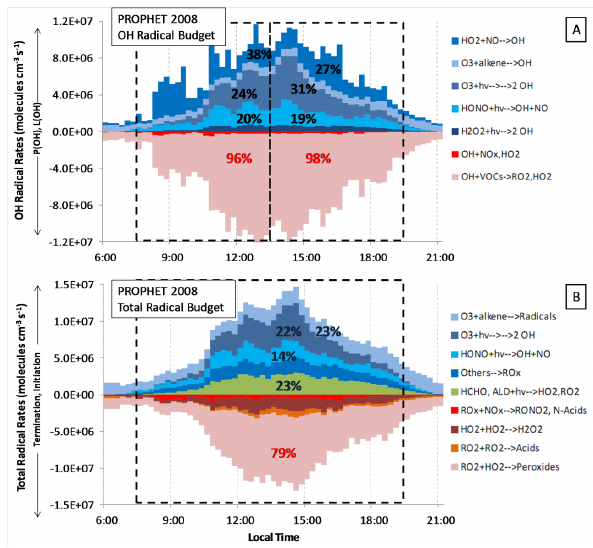
Figure 11: PROPHET 2008 radical budget diagrams showing the campaign median OH radical budget Fig. 11. PROPHET 2008 radical budget diagrams showing the cam- (A) that compares all the production and loss terms (i.e. initiation, termination, and propagation routes) paign median OH radical budget (A) that compares all the produc- for OH and the total radical budget (B) that groups and compares all initiation and termination reaction rates for OH, HO 2 , and RO 2 radicals. tion and loss terms (i.e., initiation, termination, and propagation routes) for OH and the total radical budget (B) that groups and com- pares all initiation and termination reaction rates for OH, HO 2 , and RO 2